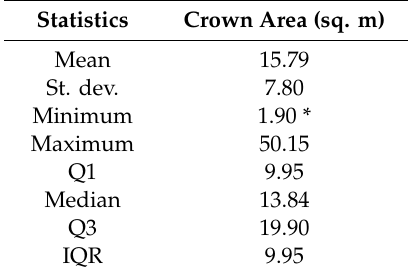
Table 2. Descriptive statistics of reference tree